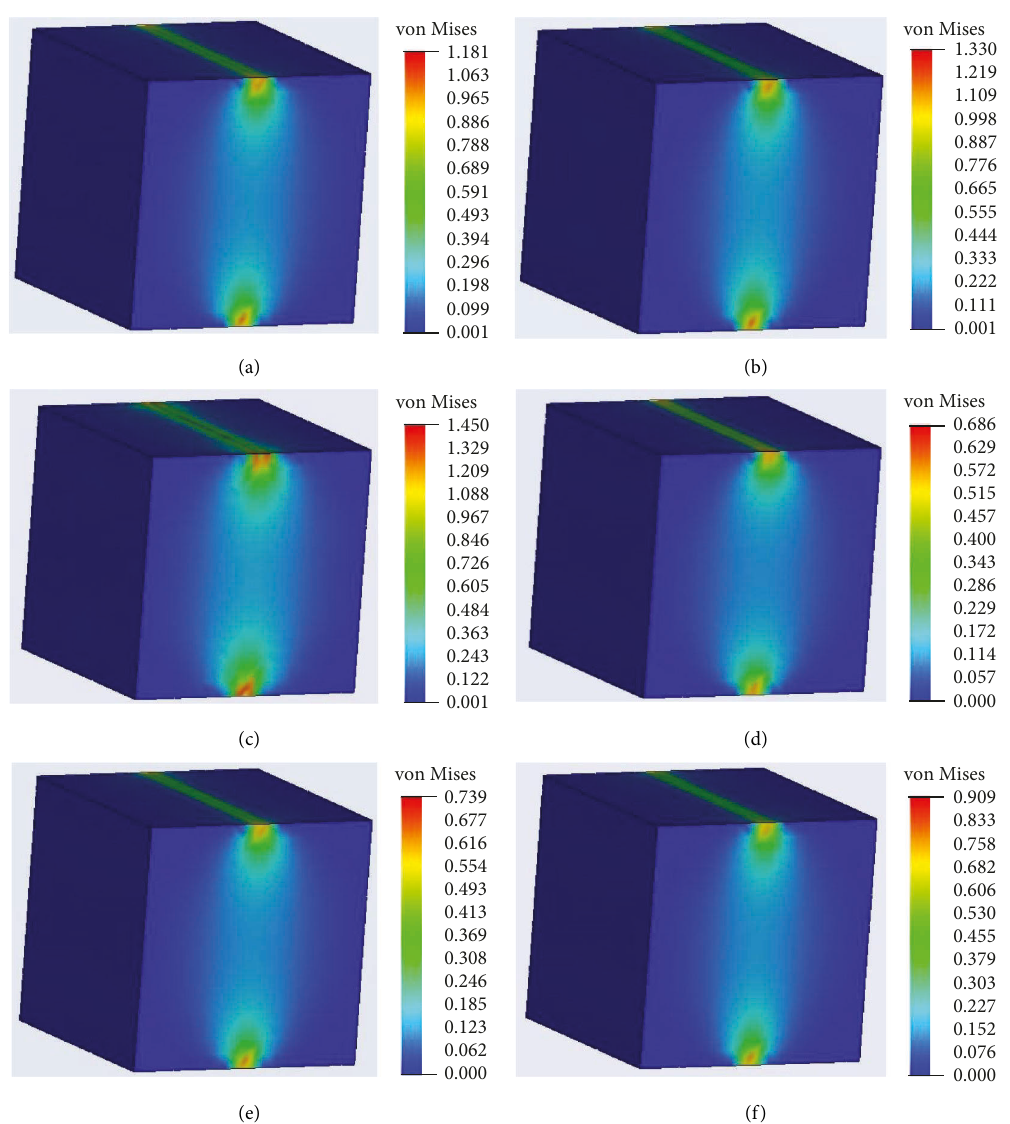
Figure 3: Stress distribution during the impact of the upper and lower jaw is shown for six samples: (a) pork meat T pork meat T 3 ; (d) poultry meat T 1 ; (e) poultry meat T 2 ; and (f) poultry meat T 3 . The color scale bar indicates gradient areas (from maximum to minimum) of von Mises stress (N/mm 2 ) in the direction of pressure.